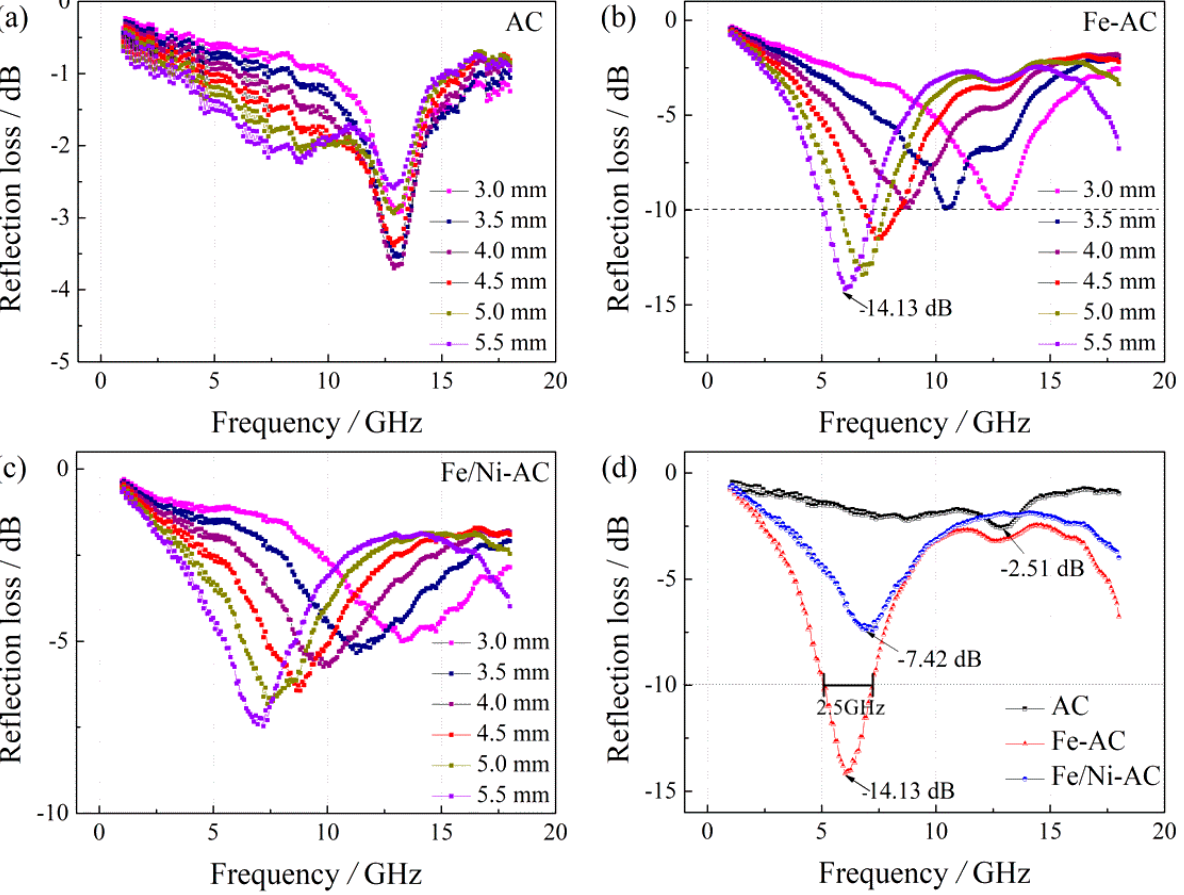
Figure 9. Reflection losses of ( a ) AC, ( b ) Fe-AC, and ( c ) Fe/Ni-AC ( t from 3.0 mm to 5.5 mm), and ( d ) the reflection losses ( t = 5.5 mm) of those samples.